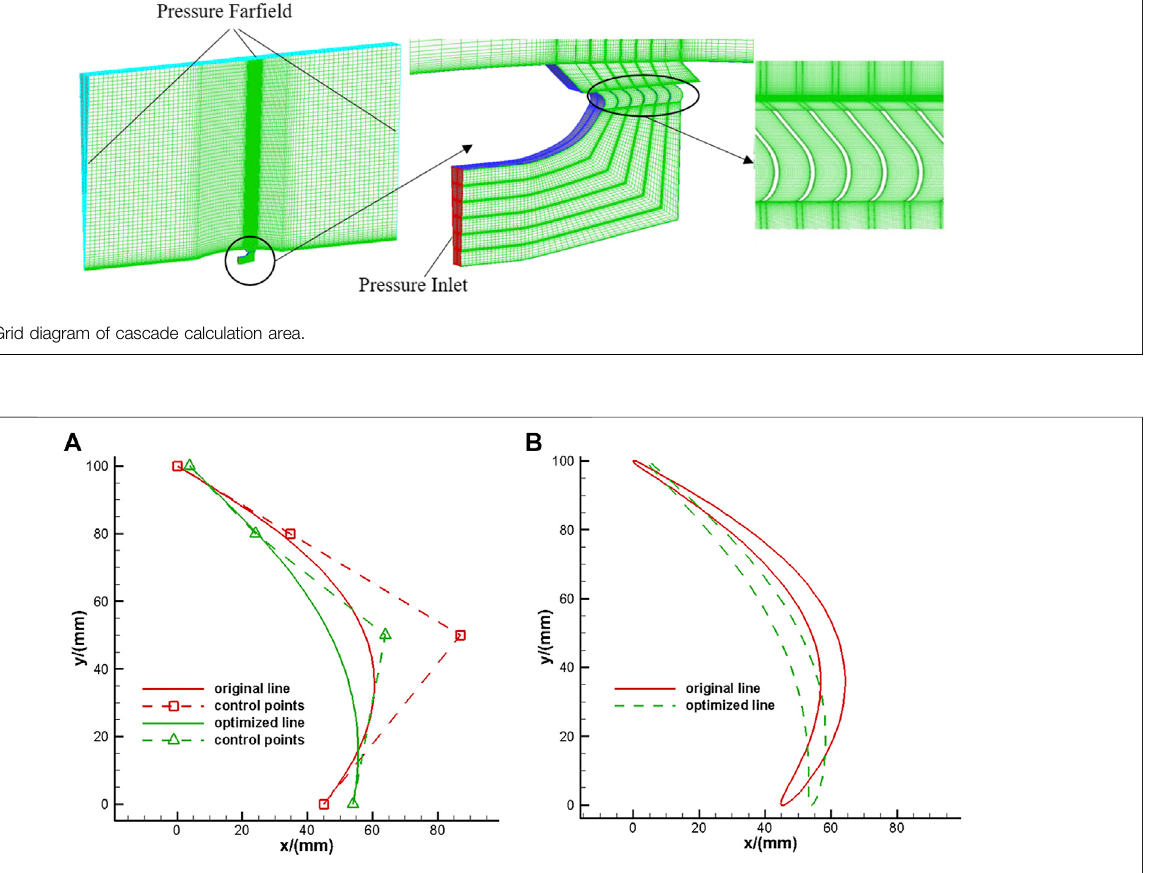
FIGURE 10 | Blade comparison. (A) Blades of equal thickness (B) Blades of unequal thickness.